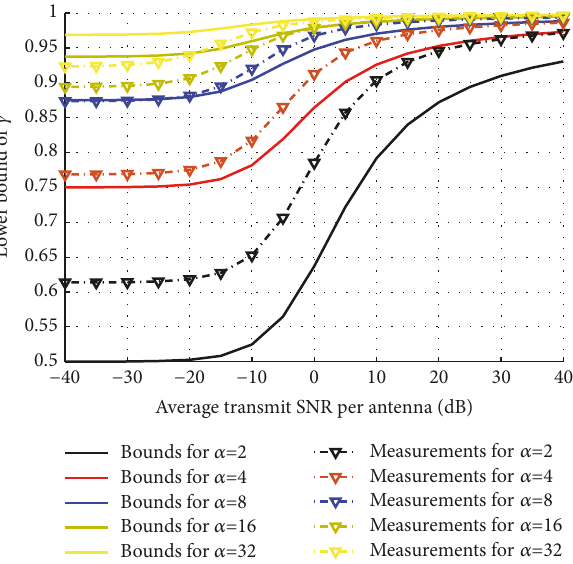
Figure 4: The 3.5 GHz measurement results and the lower bounds of 𝛾 with respect to the average transmit SNR for different DoF of the system.